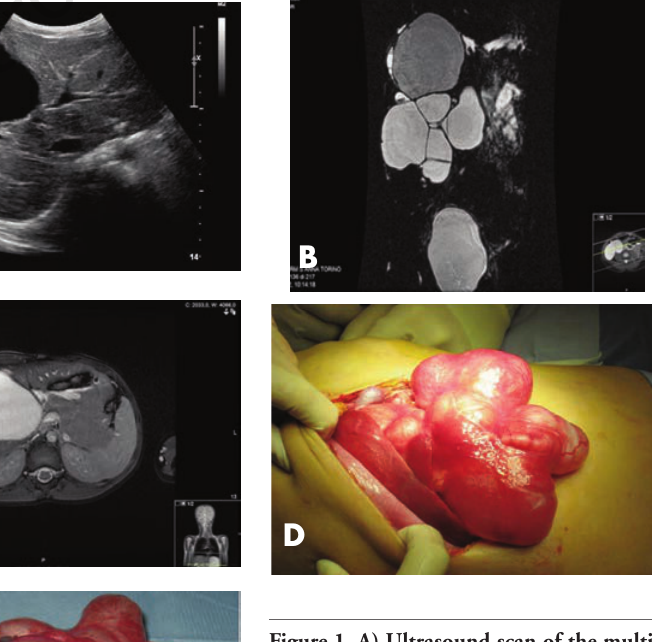
Figure 1. A) Ultrasound scan of the multi- loculated cystic mass of the hepatobiliary cystadenoma. B) Computed tomography scan coronal view of the multiloculated, thinly septated cystic mass in the right upper abdomen described in the first case. C) Computed tomography scan transver- sal view of the mass. D) Intraoperative findings. E) Excised mass after atypical hepatic